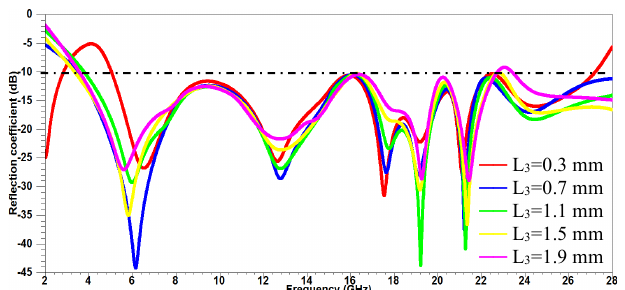
Figure 8: Simulated reflection coefficient for various length of L 3 .